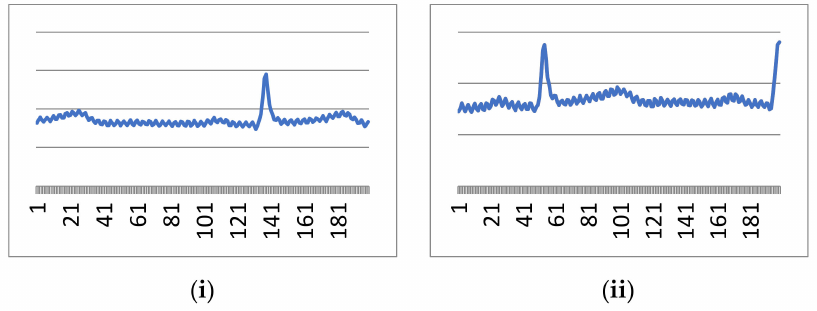
Figure 6. First 200 samples from ( i ) signal 1 and ( ii ) signal